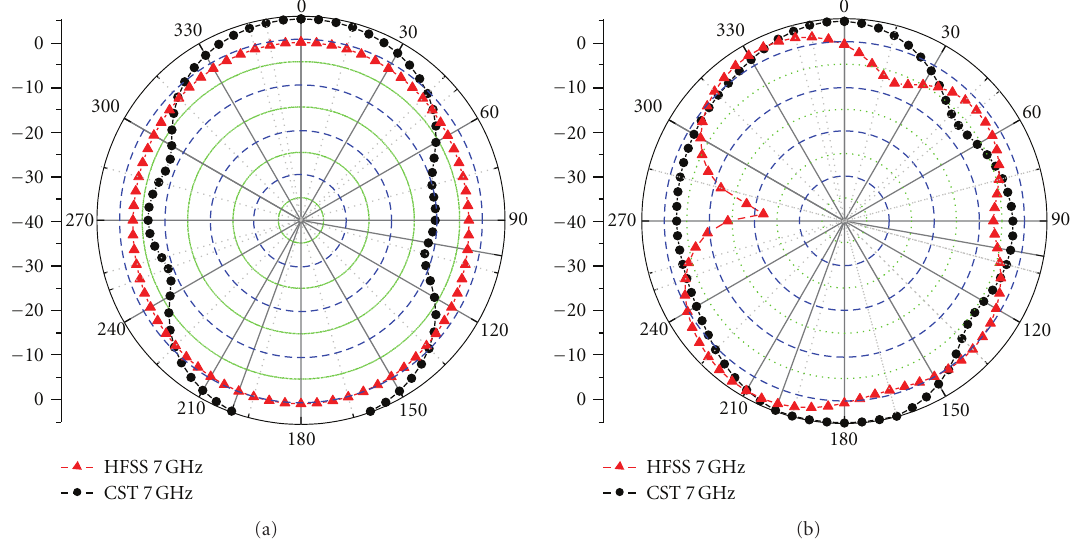
Figure 9: Radiation patterns of the proposed antenna at 7 GHz; (a) xoz-plane, (b) yoz-plane.